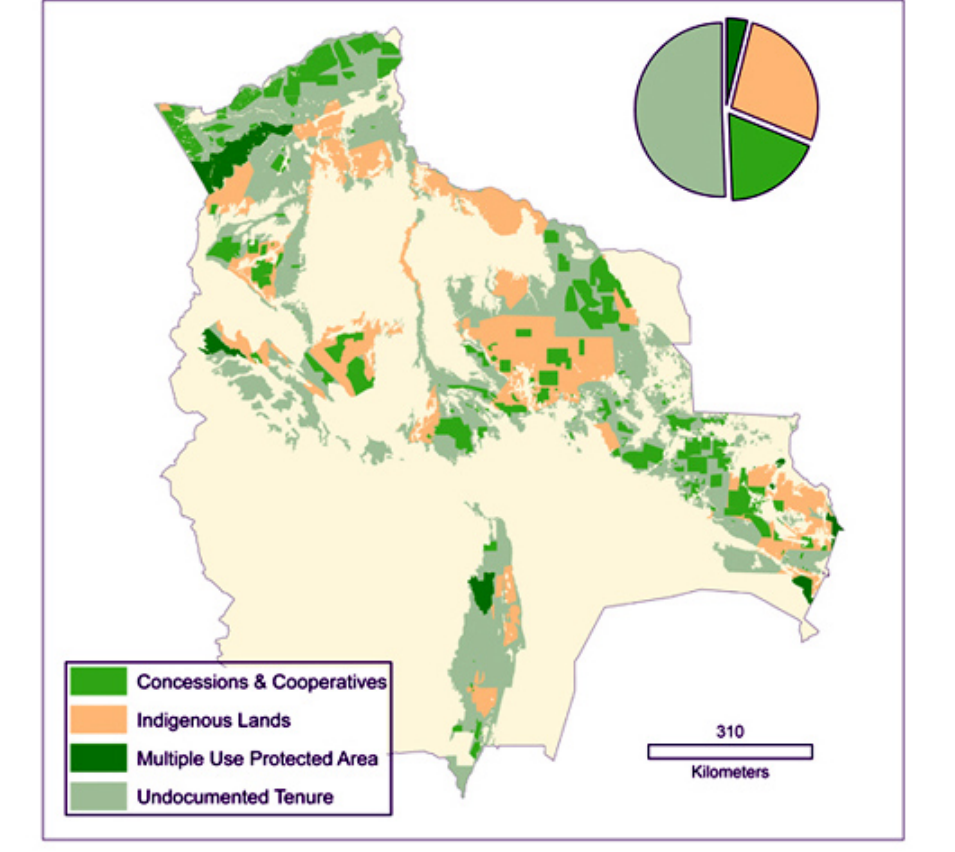
Fig. 7. The distribution of forest-use rights within the forest products sector. Private companies and cooperatives are pooled; indigenous communities include both lands legally ceded to them and outstanding demands; and multiple-use protected areas are part of the national protected area system. Lands that have undocumented tenure often have multiple claims for competing